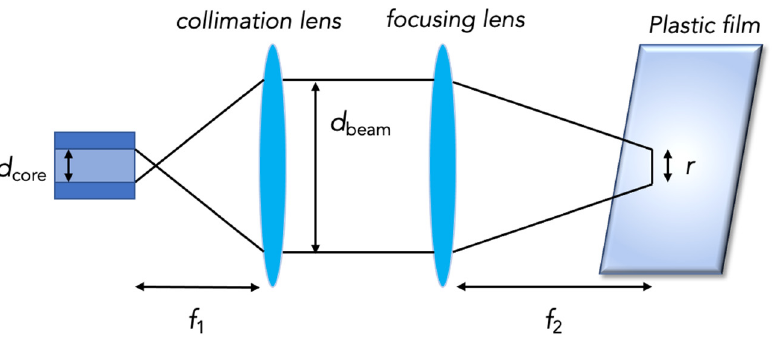
Figure 8. Optical head: collimation optics and beam